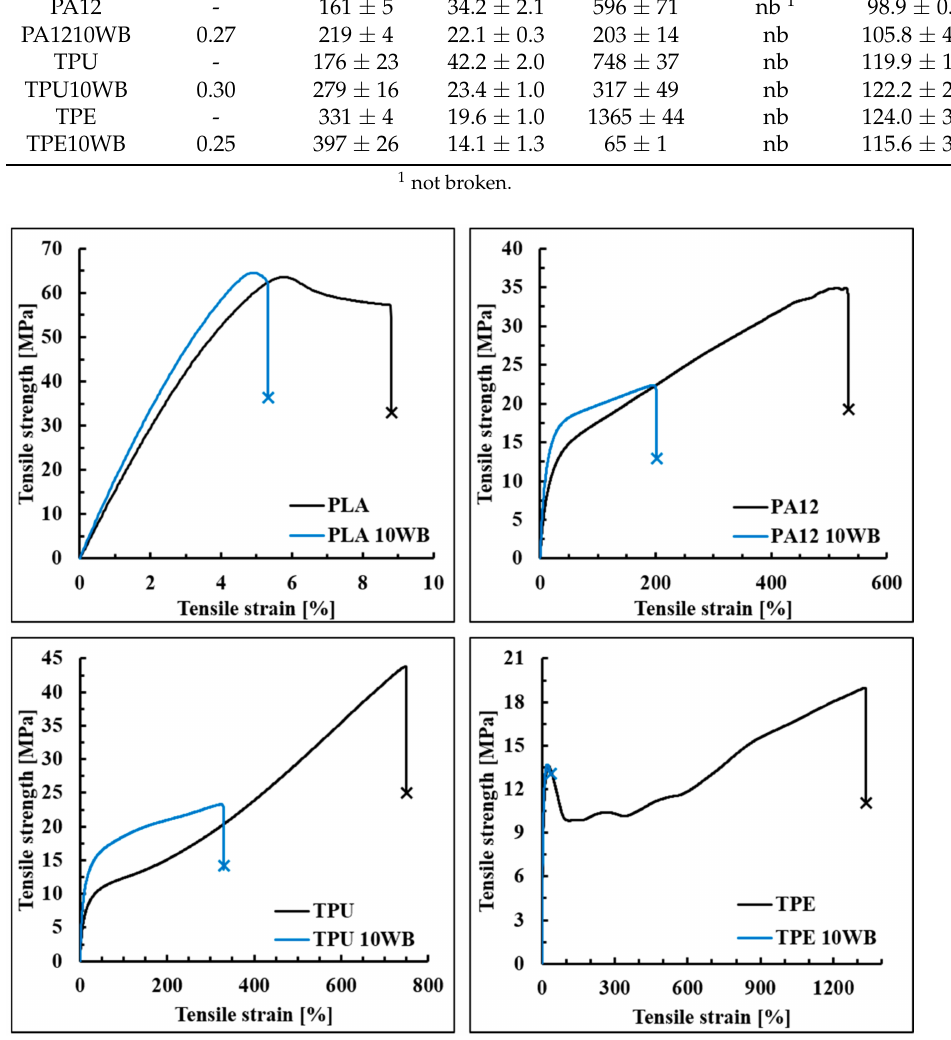
Figure 5. Tensile behavior of WB-based composites. The SEM images of the WB-based samples taken at low magnification (200 × ) and their corresponding EDS maps are reported in Figure 6. It is possible to notice that within TPU and TPE matrices, WB fibers formed aggregates and they were not homogenously distributed through the polymer matrix (Figure 6c,d). In contrast, the distribution and dispersion of WB fibers was still good within PA1210WB and excellent within PLA. In the case of PLA, the excellent dispersion and distribution is also due to the fact that WB fibers appear de-fibered and branched in nanofibers, which therefore occupy the polymer matrix better and more uniformly. These tiny WB fibers are depicted in Figure 7, from which it can also be noticed how they are perfectly bonded with the polymer (Figure 7c), since the decrease in the fiber diameter enhances the fiber–matrix interface and the fiber wettability